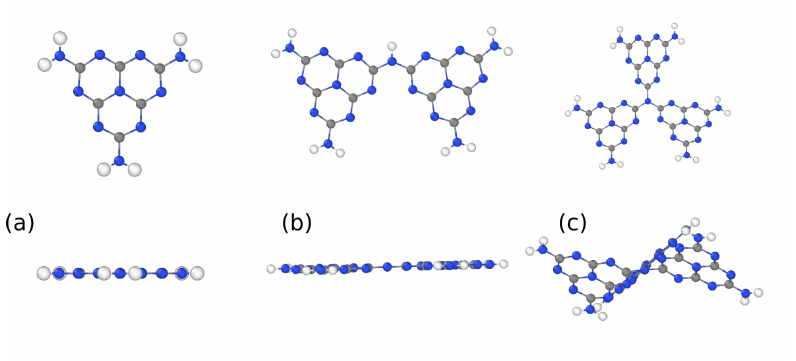
Figure 2. Top and front views of the optimized structures of melem ( a ) monomer, ( b ) dimer and ( c ) trimer. Blue, gray, white spheres represent N, C, H atoms